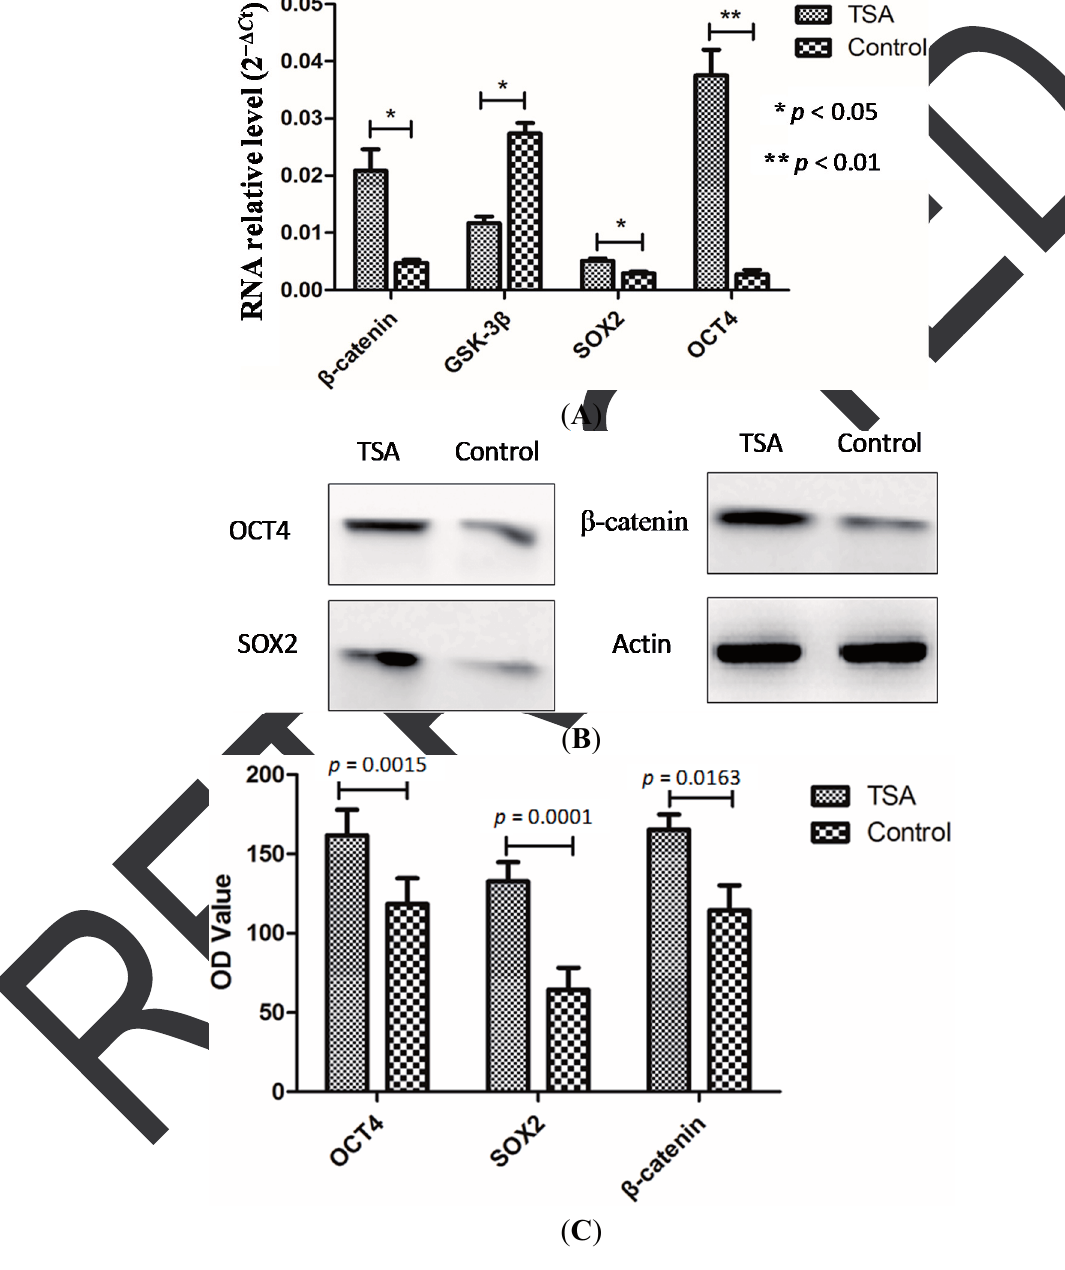
Figure 2. Epidermal cells showed activated Wnt signaling and enhanced stemness after pretreatment with TSA. qRT-PCR showed upregulation of β-catenin, SOX2, OCT4 and downregulation of GSK-3β in TSA-pretreated epithelial cells compared with control cells ( A ); Similar results were obtained using Western blot analysis ( B , C